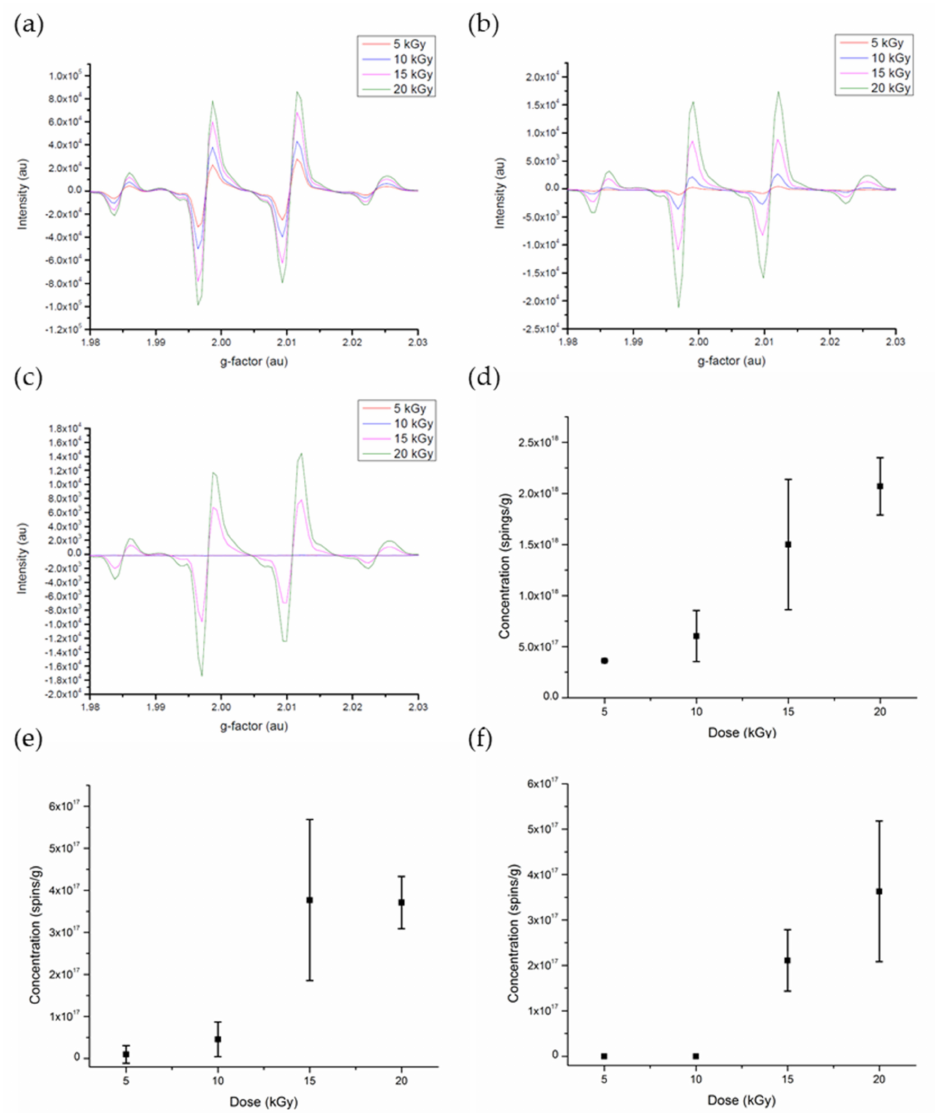
Figure 2. ( a – c ) Time series of EPR spectra for PLA irradiated at 4 different doses: 5 kGy (red), 10 kGy (blue), 15 kGy (pink), and 20 kGy (green). There were three time points used: ( a ) same day as irradiation (day 0); ( b ) day following irradiation (day 1); ( c ) second day following irradiation (day 2). ( d – f ) Dose–yield plots over the first three days. These measurements were taken twice at 5 kGy, twice at 10 kGy, four times at 15 kGy, and twice at 20 kGy . ( d ) Day 0; ( e ) day 1; ( f ) day